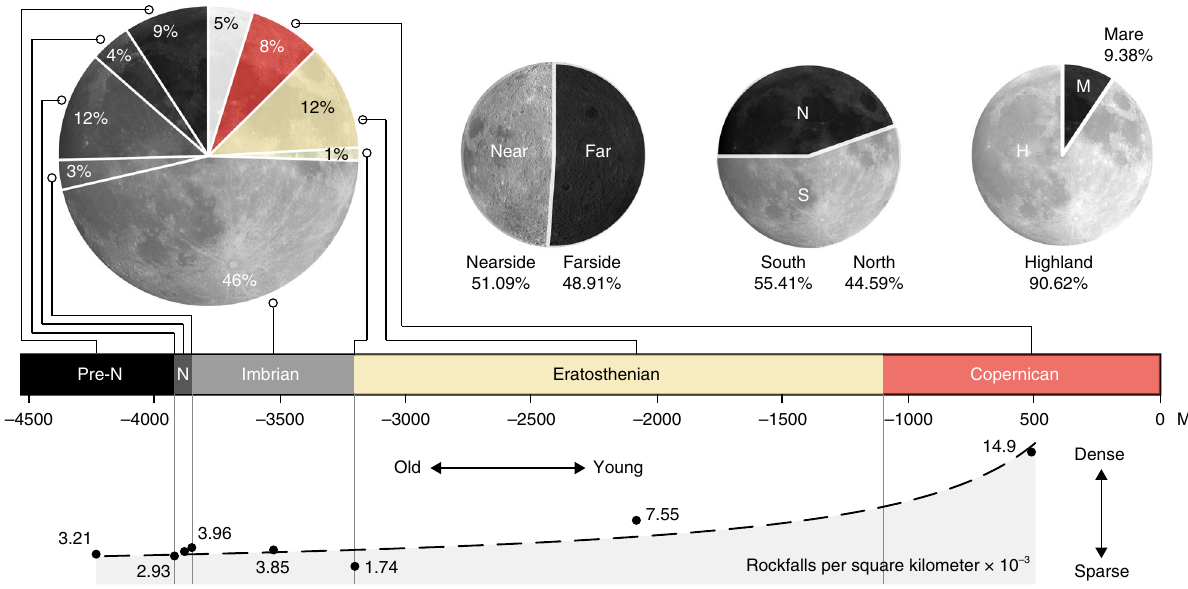
Fig. 3 Statistics about rockfall distribution in space and time. Statistics highlight the spatial distribution of rockfalls and its implications. More rockfalls occur in highland terranes and the majority of rockfalls occur in Imbrian terranes, while Nectarian (N) and even pre-Nectarian sites (pre-N) feature a substantial number of recent rockfalls (~25%). Owing to inaccuracies in the underlying geologic map, the number of rockfalls in ancient terranes is potentially reduced in favor of the Copernican and Eratosthenian bins (see Supplementary Fig. 5). The normalization of the CNN-derived rockfall counts over area in the regions provides a fi rst-order estimate (power law fi t, black dashed line) of the advective erosion rate of the lunar topography and its evolution over time (Eq. (1) in the “ Methods ” section). Geologic lunar timescale based on refs. 56,57